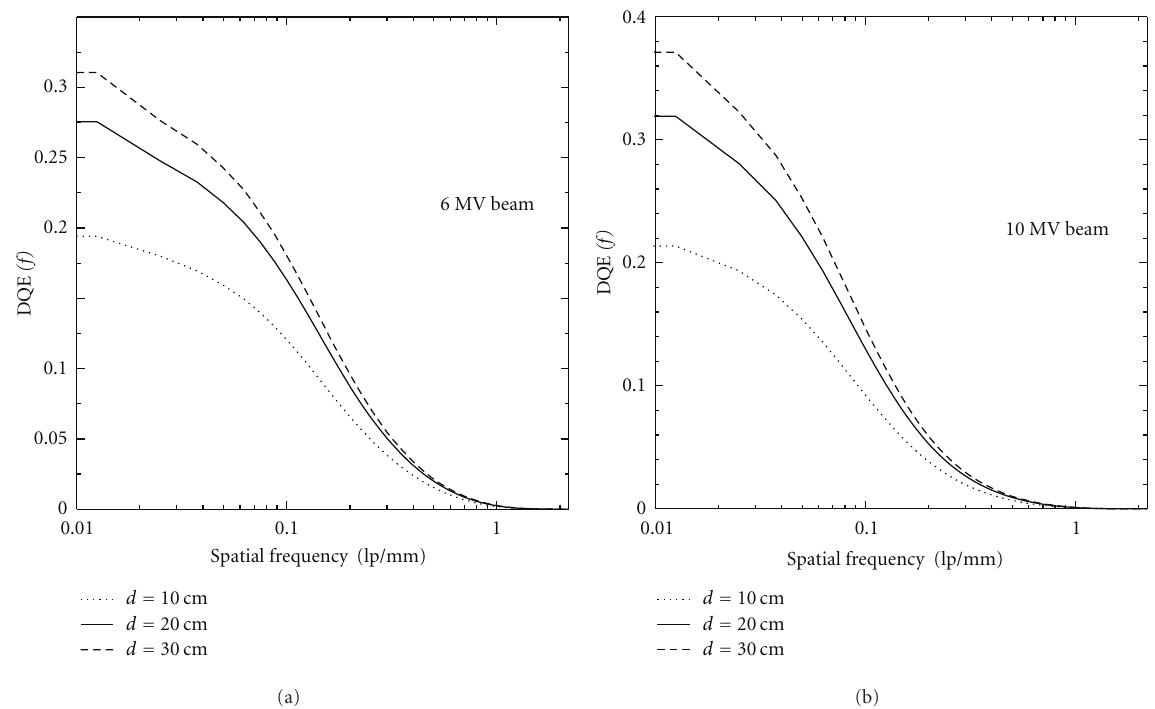
Figure 13: The DQE as a function of spatial frequency, obtained from (8), for di ff erent detector thicknesses and X-ray spectra.